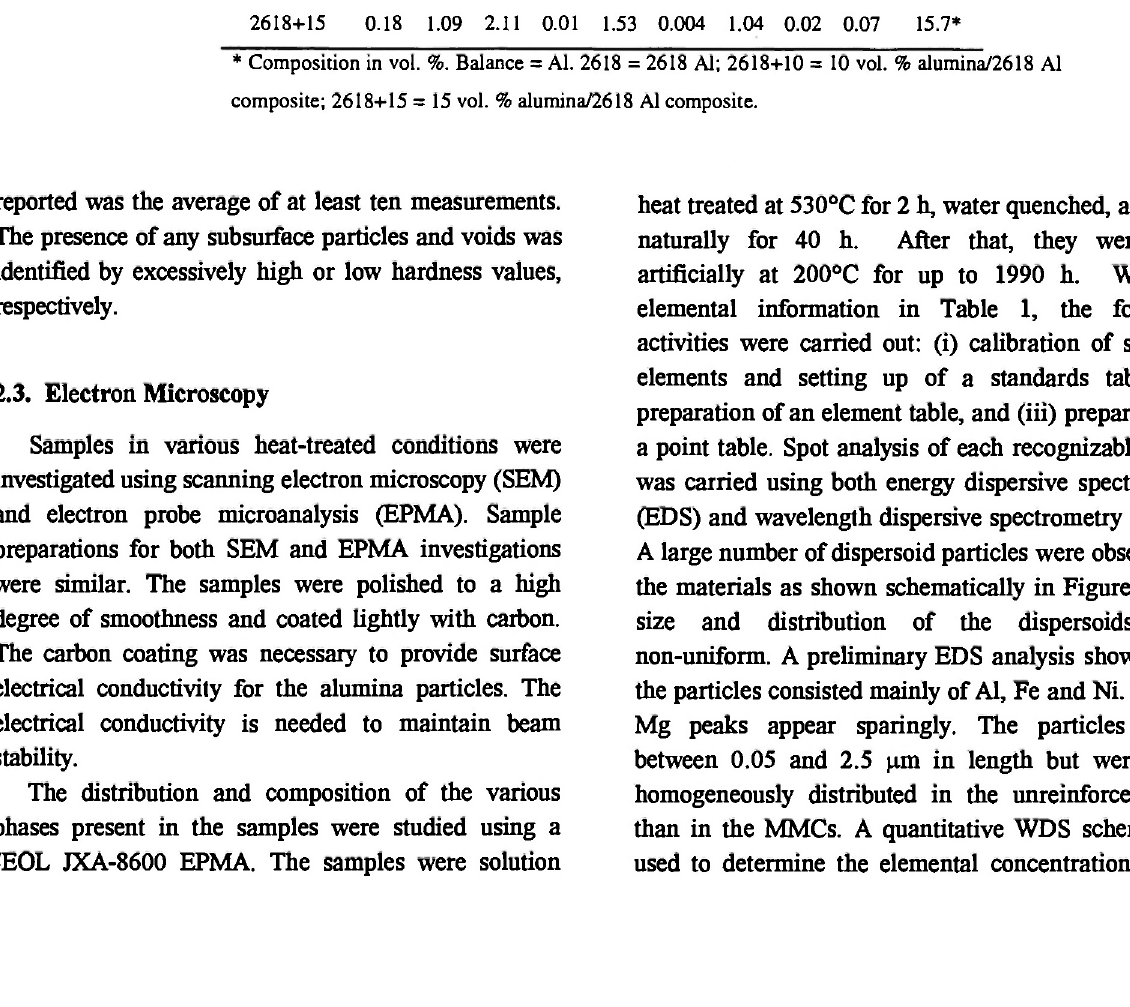
Composition of Experimental